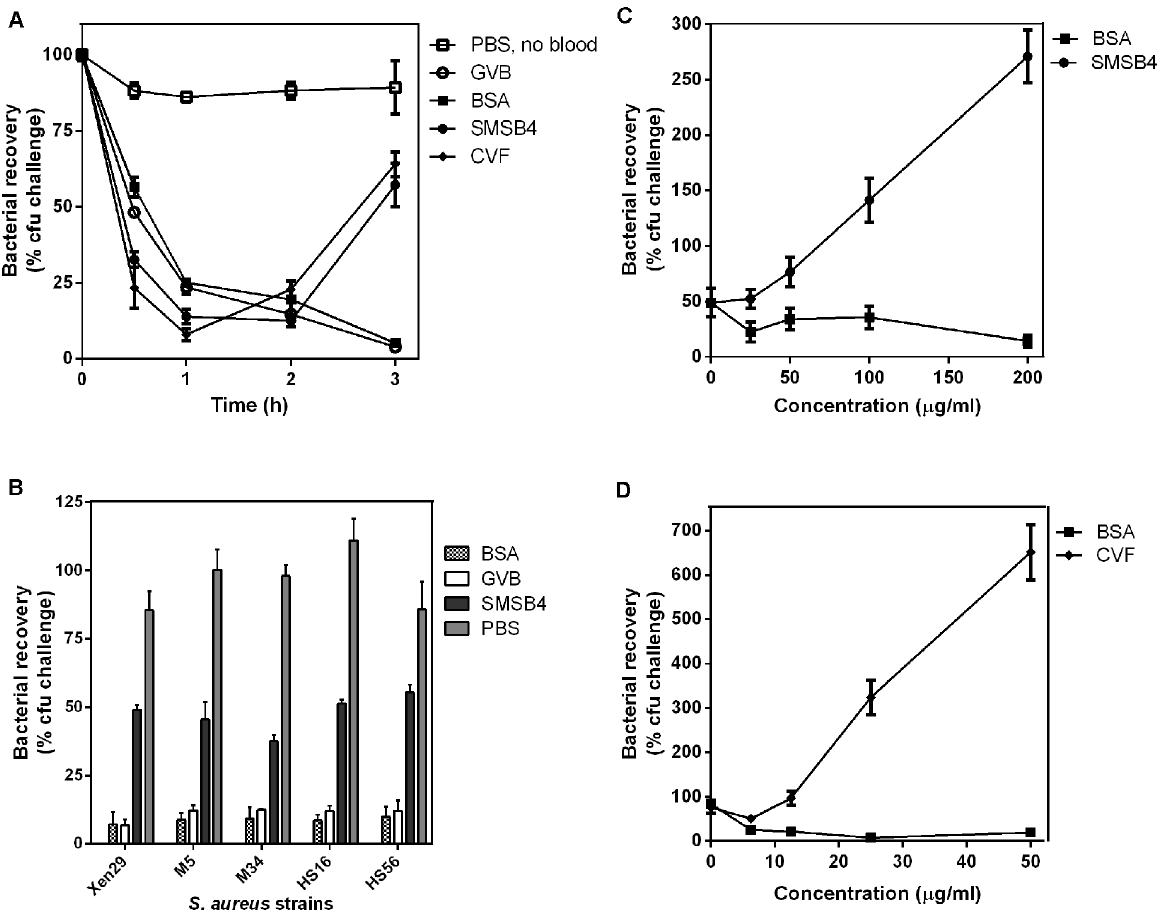
Figure 1. SMSB4 reduces the blood killing of S.aureus strain Xen29 in whole blood ( A ) and pyoderma isolates of S.aureus ( B ). SMSB4 promotes bacteria growth in a concentration dependent manner (C) similarly to CVF (D). S. aureus Xen29 or pyoderma isolates MRSA strains (HS16, M34), MSSA strains (HS56, M5) were harvested from mid-log growth phase culture. Bacteria (1 6 10 5 cfu/ml) were challenged with whole blood pre- treated with either 100 m g/ml SMSB4, positive control 10 m g/ml CVF, negative controls 100 m g/ml BSA or GVB 2 + buffer only. S. aureus cells in PBS only without blood was also included to illustrate that the reduction in bacteria number was due to blood killing ( A ). Numbers of bacteria were counted as cfu/ml at various time points ( A ) or at 3 h ( B , C , D ). Bacterial recovery was calculated as a percentage of the challenge dose. Results are shown as means 6 SEM from three independent experiments. The statistical significance of differences between samples was estimated using two way ANOVA with Tukey’s multiple comparison test. **, p , 0.01; ***, p , 0.001; ****, p , 0.0001, ns, not significant